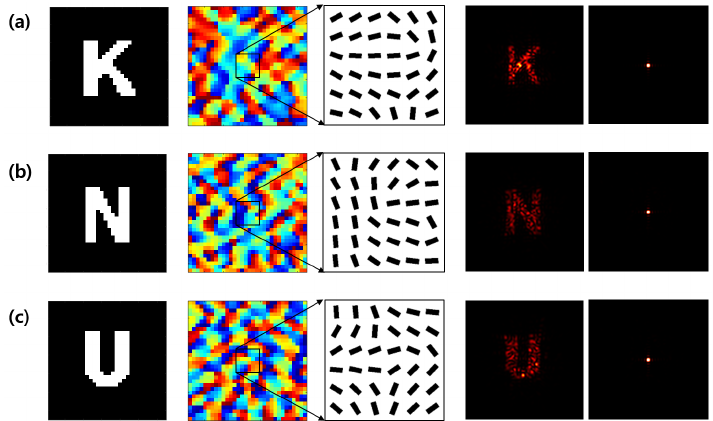
Figure 5. Switchable Fourier hologram generated by VO 2 based reflectarray metasurface with the character ( a ) K ( b ) N, and ( c ) U. The columns from the left to the right indicate the original binary image, phase map, magnified in-plane cut-view of Au nanorod array, and reconstructed far-field images with λ = 700 nm projected in the polar coordinate at low temperature and high